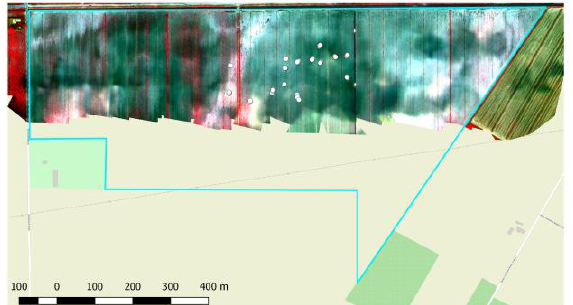
Figure 6. Multispectral ortho-mosaic displayed as RGB false colour composite (R=NIR, G=red, B=green) with overlaid ESU positions (white dots) and field borders (cyan polygon).